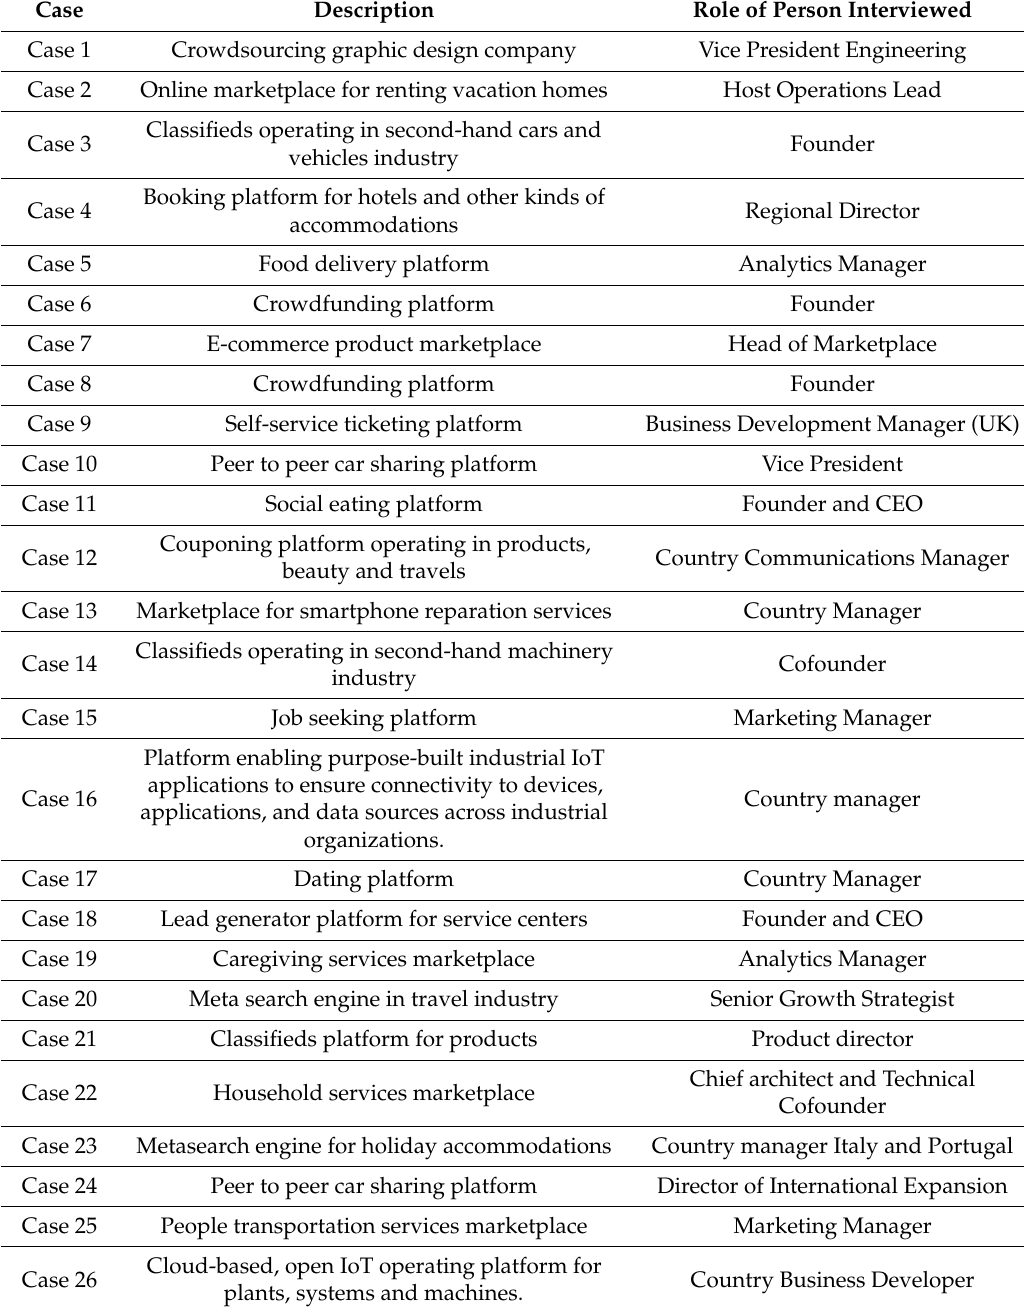
Table 3. Case studies